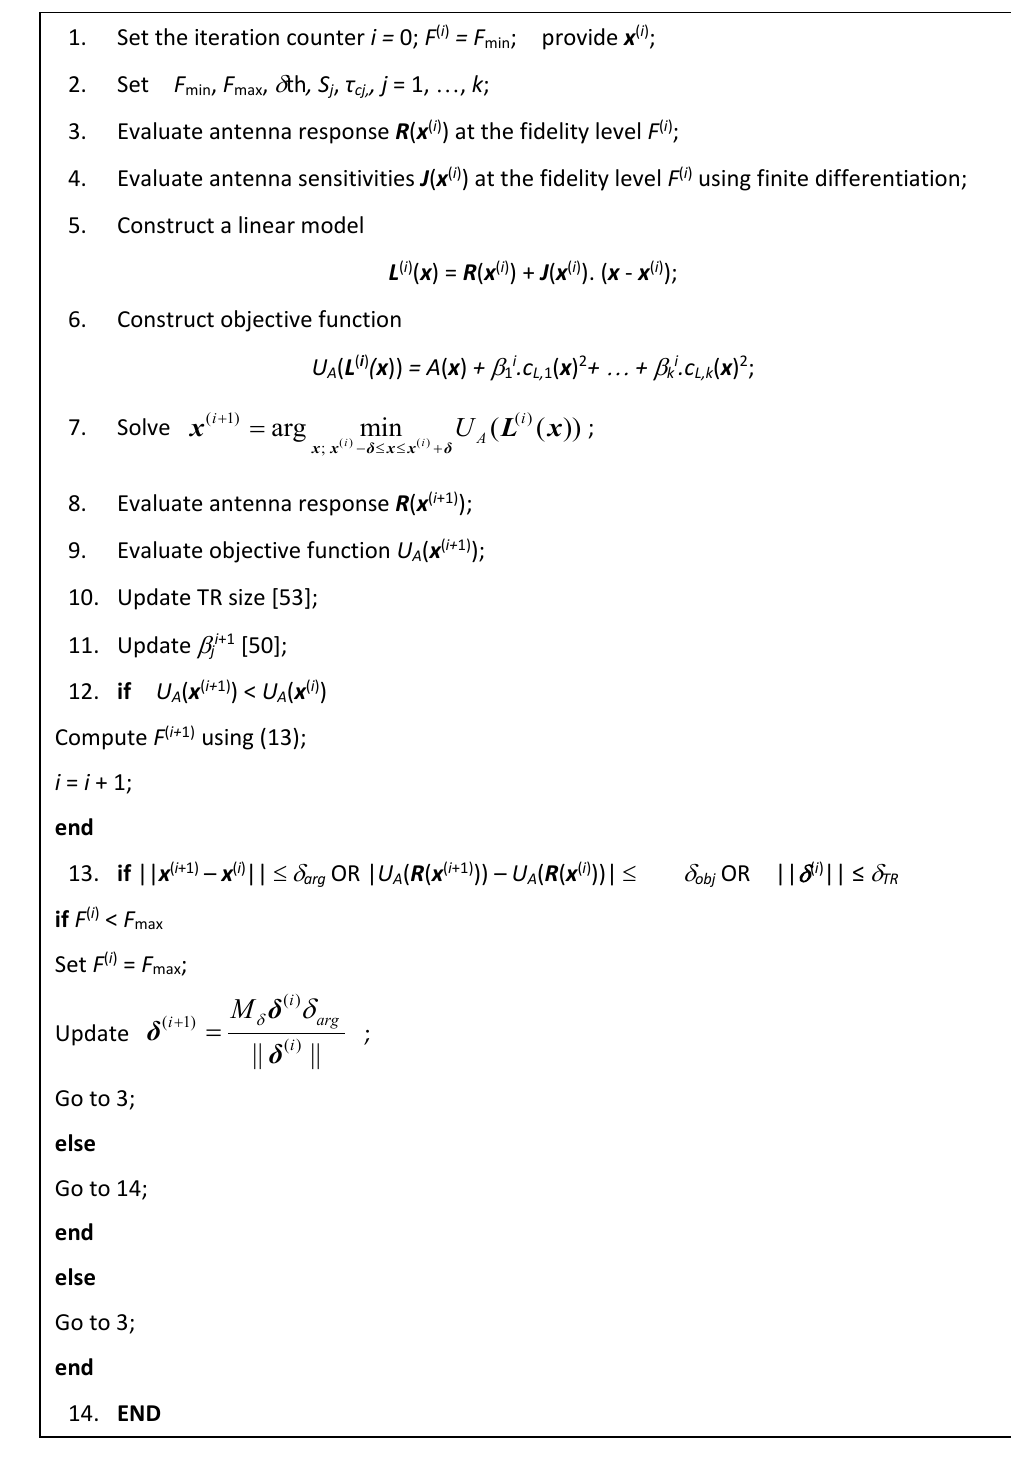
Figure 4. Operation of the proposed optimization algorithm incorporating adaptive adjustment of penalty coefficients.